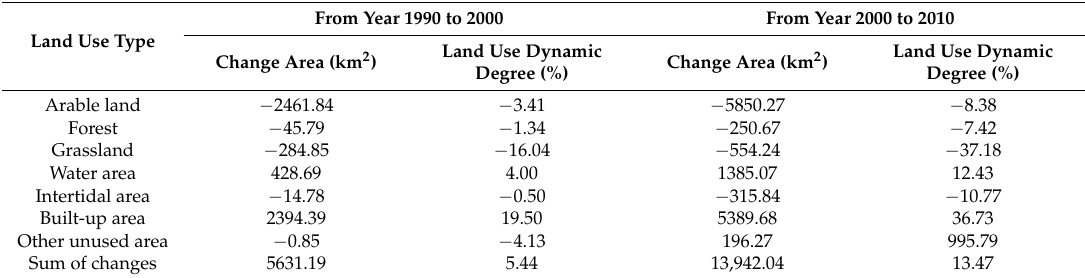
Table 5. The land use dynamic degree of Jiangsu province from 1990 to